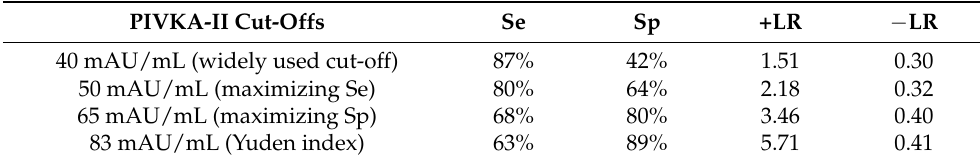
Table 2. Sensitivity, specificity, positive, and negative likelihood ratio of PIVKA-II values according to different cut-offs.